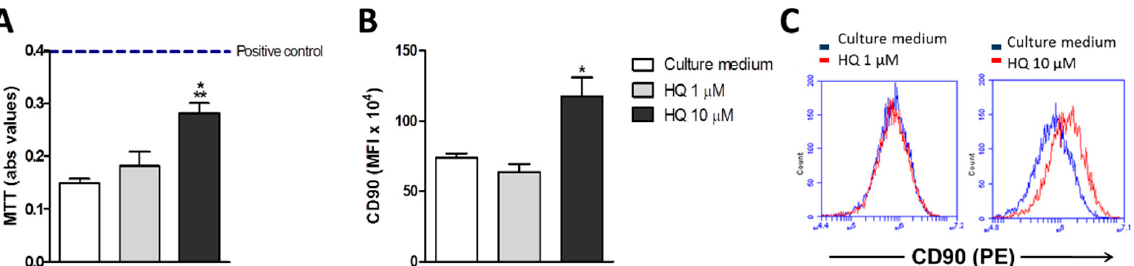
Figure 1. In vitro HQ exposure enhances the viability of RAHFLS. RAHFLS (1 × 10 4 cells) were incubated with culture medium or with HQ (1 or 10 µ M) for 24 h, and had their viability and ability to proliferate determined through the MTT method ( A ) and the flow cytometry method based on the staining with an anti-CD90 antibody ( B , C ). Data represent mean ± SEM from three independent experiments and were analyzed by one-way ANOVA ( A ): ** p < 0.01 vs. culture medium; * p < 0.05 vs. HQ 1 µ M; ( B ): * p < 0.05 vs. culture medium and vs. HQ 1 µ M. ( A ): positive control: DMEM F12 culture medium supplemented with 10% FBS.